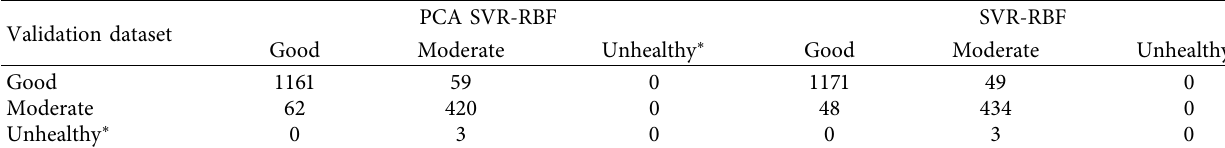
Table 13: Confusion matrix for the AQI classifications obtained with both models for the validation